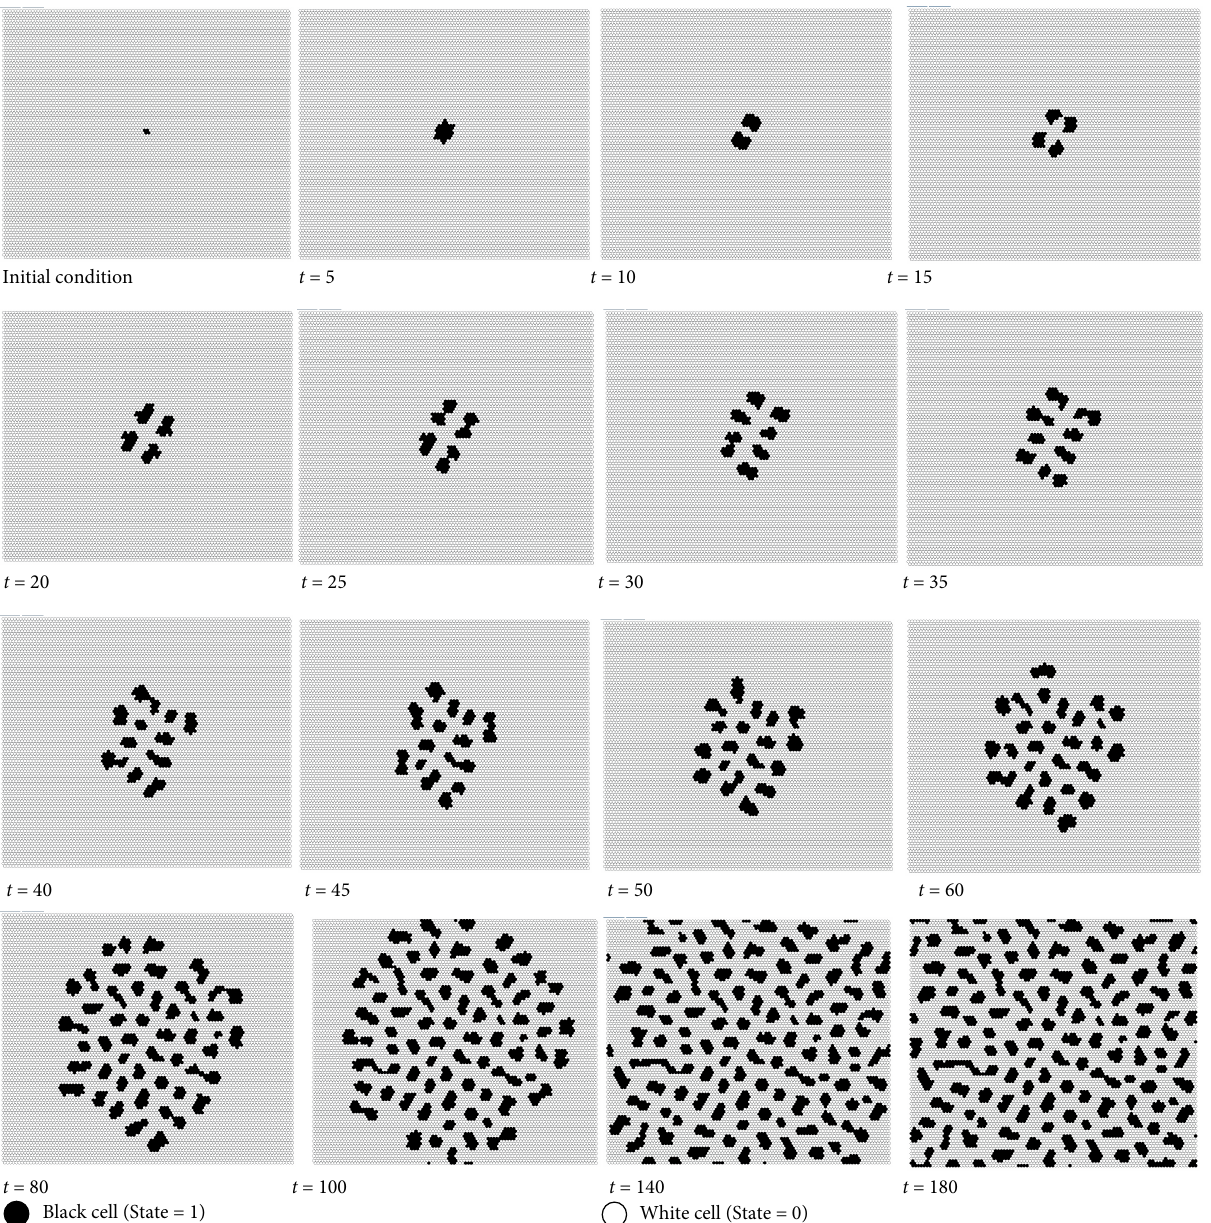
Figure 7: Process of forming a spotted pattern. Here, 𝑡 is the iteration number. The initial single spot at the center divides in two, as does each subsequent spot. The simulated space is covered with a spotted pattern that is similar to that in the Gray–Scott